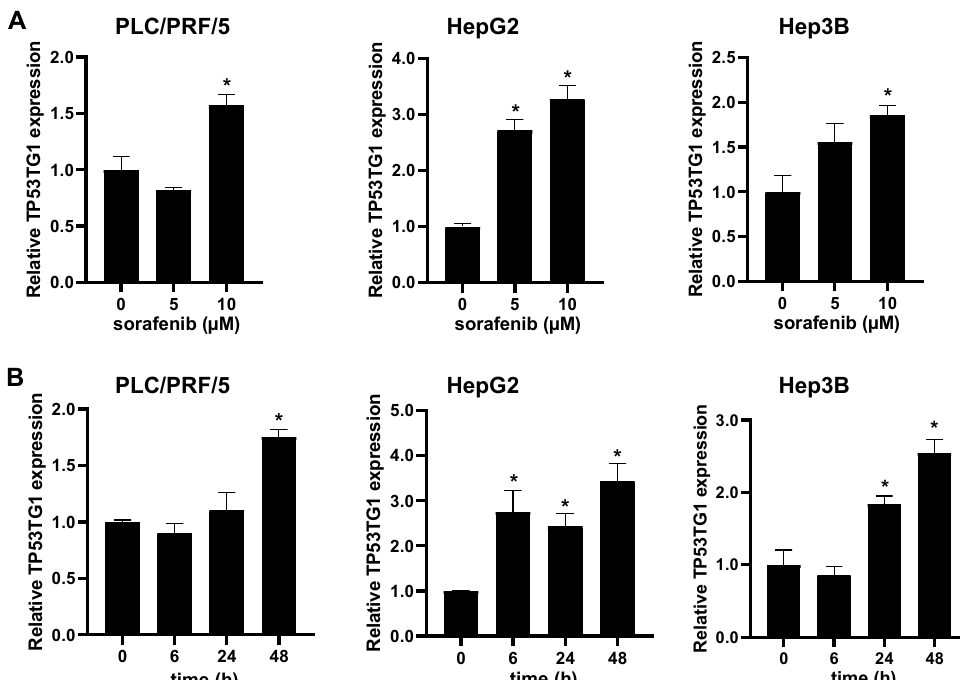
Figure 1. TP53TG1 is upregulated by sorafenib in HCC cells. ( A ) RNA expression levels of TP53TG1 in PLC/PRF/5, HepG2, and Hep3B cells treated with 0, 5, or 10 µM of sorafenib for 48 h ( n = 3); ( B ) RNA expression levels of TP53TG1 in PLC/PRF/5, HepG2, and Hep3B cells treated with 10 µM sorafenib for 0, 6, 24, and 48 h ( n = 3). Error bars are shown as standard error of the mean (SEM), * p < 0.05.